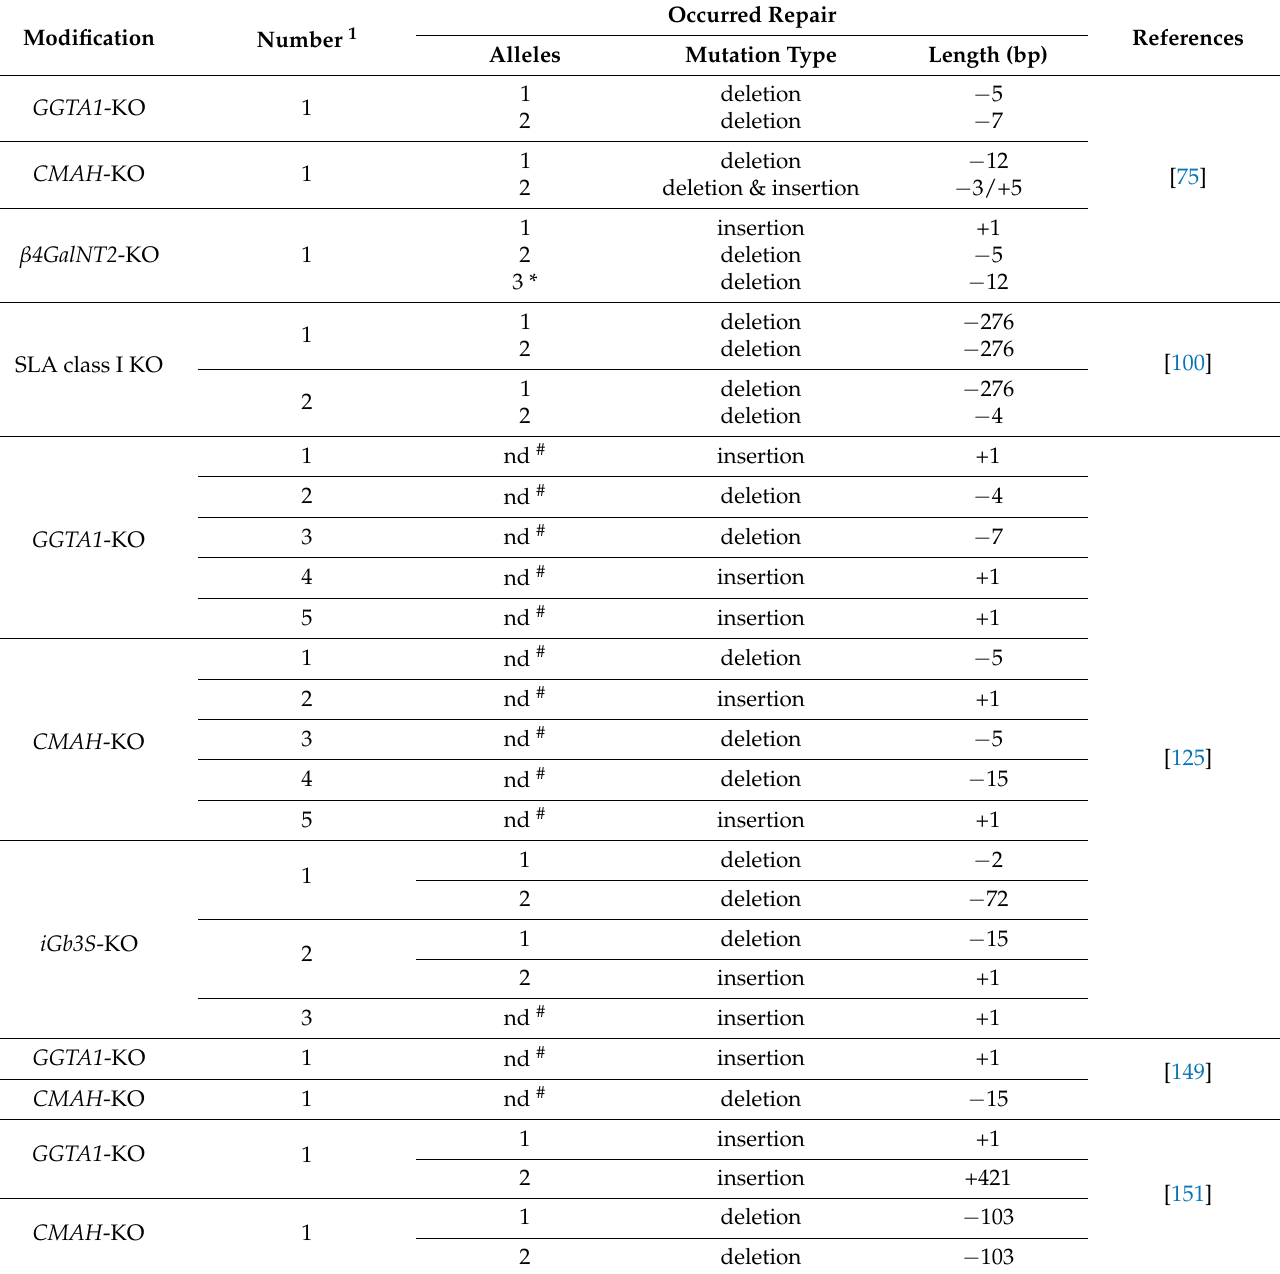
Table 2. Summary of genetic changes introduced by the CRISPR/Cas system into the porcine genome for xenotransplanta- tion